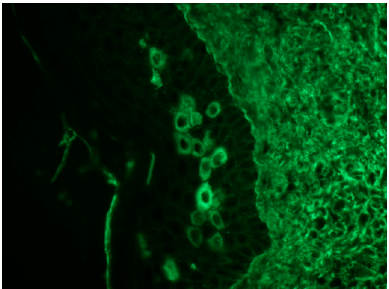
Figure 6. Basal cell vacuolar degeneration, dyskeratotic and necrotic keratinocytes, lymphocytic inflammation with lymphocytic exocytosis. (H&E, magnification 30×).